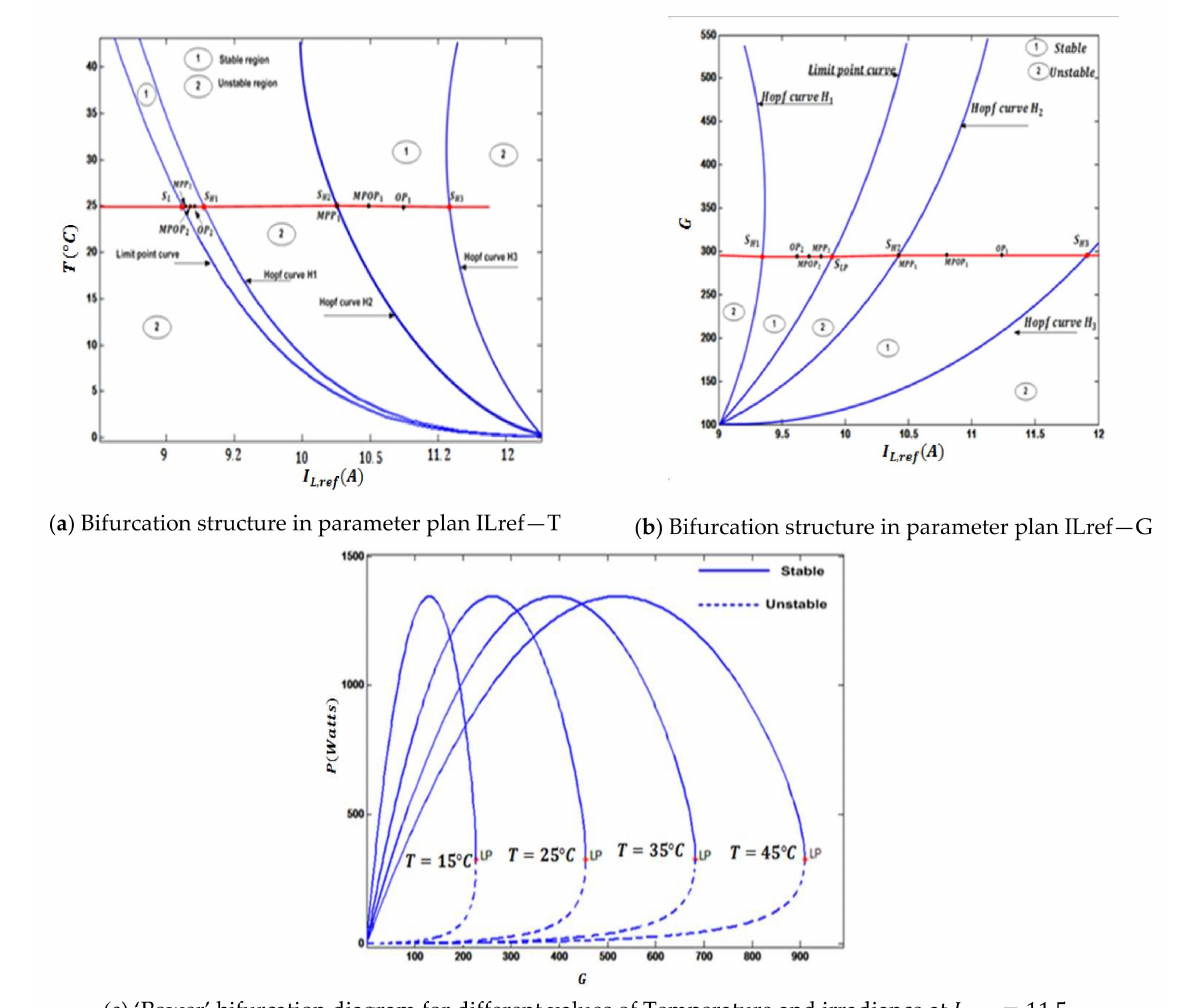
Figure 9. Bifurcation structure in varying parameter